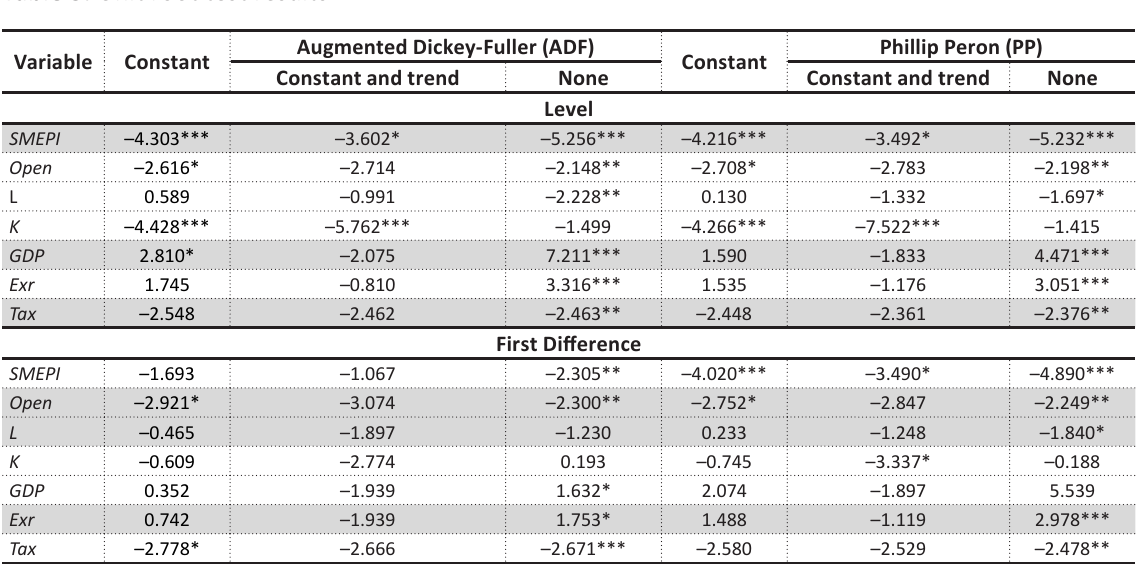
Table 3. Unit root test